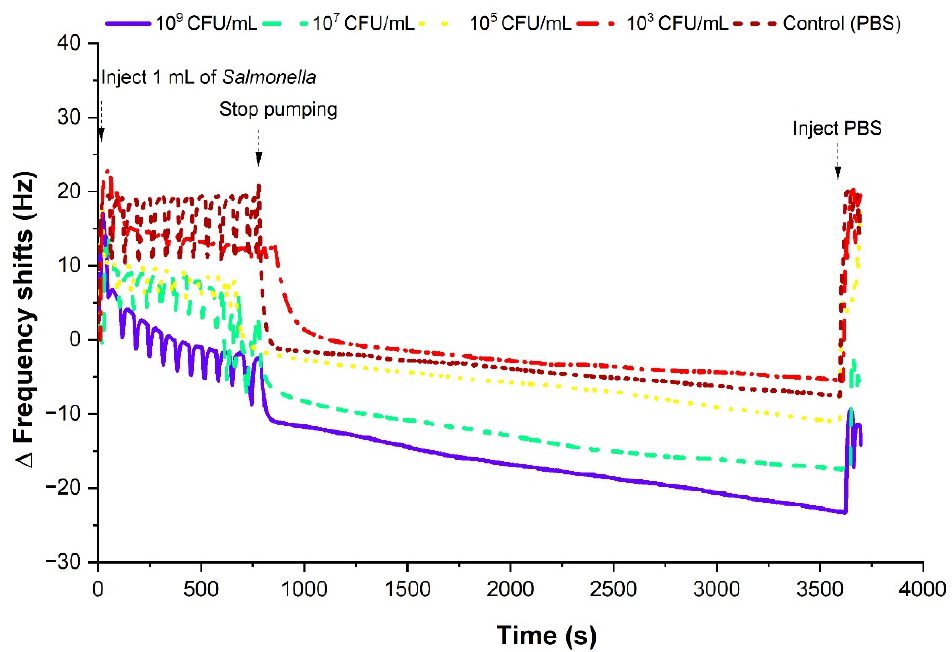
Figure 7. Frequency responses immediately after Salmonella Typhimurium injection. Large gaps can be observed between the high and low concentration due to the change in mass. Each graph represents a single measurement.